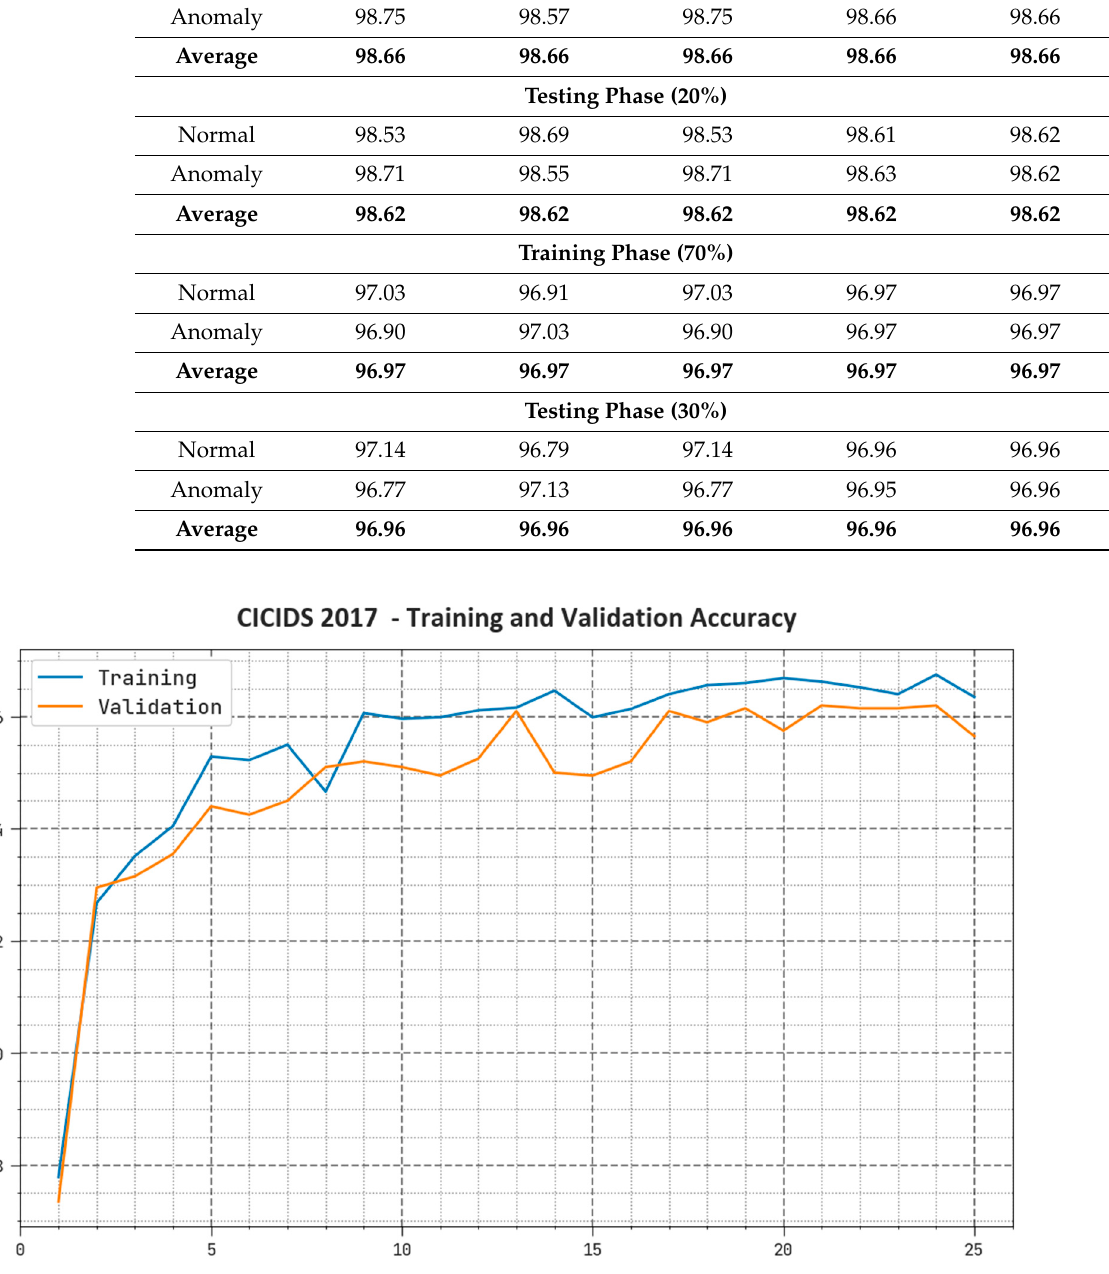
Table 3. Intrusion recognition outcome of XAIID-SCPS system on the CICIDS 2017 dataset.